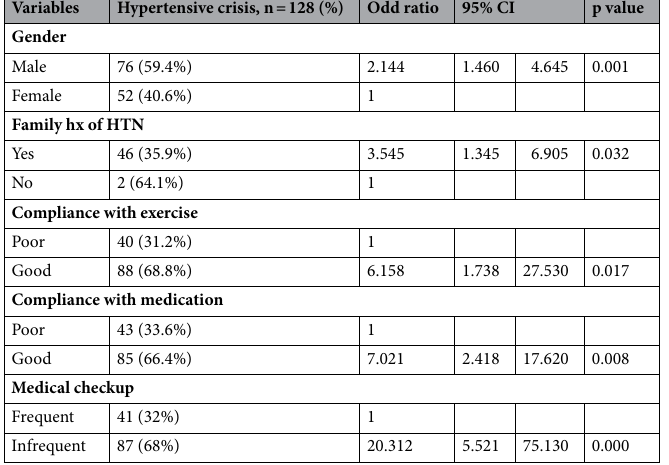
Table 5. Predictors of hypertensive